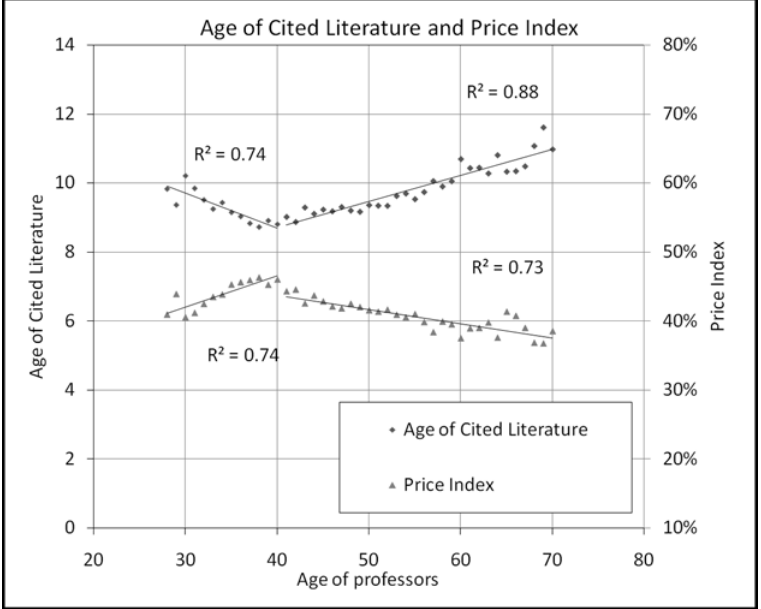
Figure 3. Distribution of age of cited references and percentage of those references that are 5 years or younger (Price Index for references of 100 years old or less).